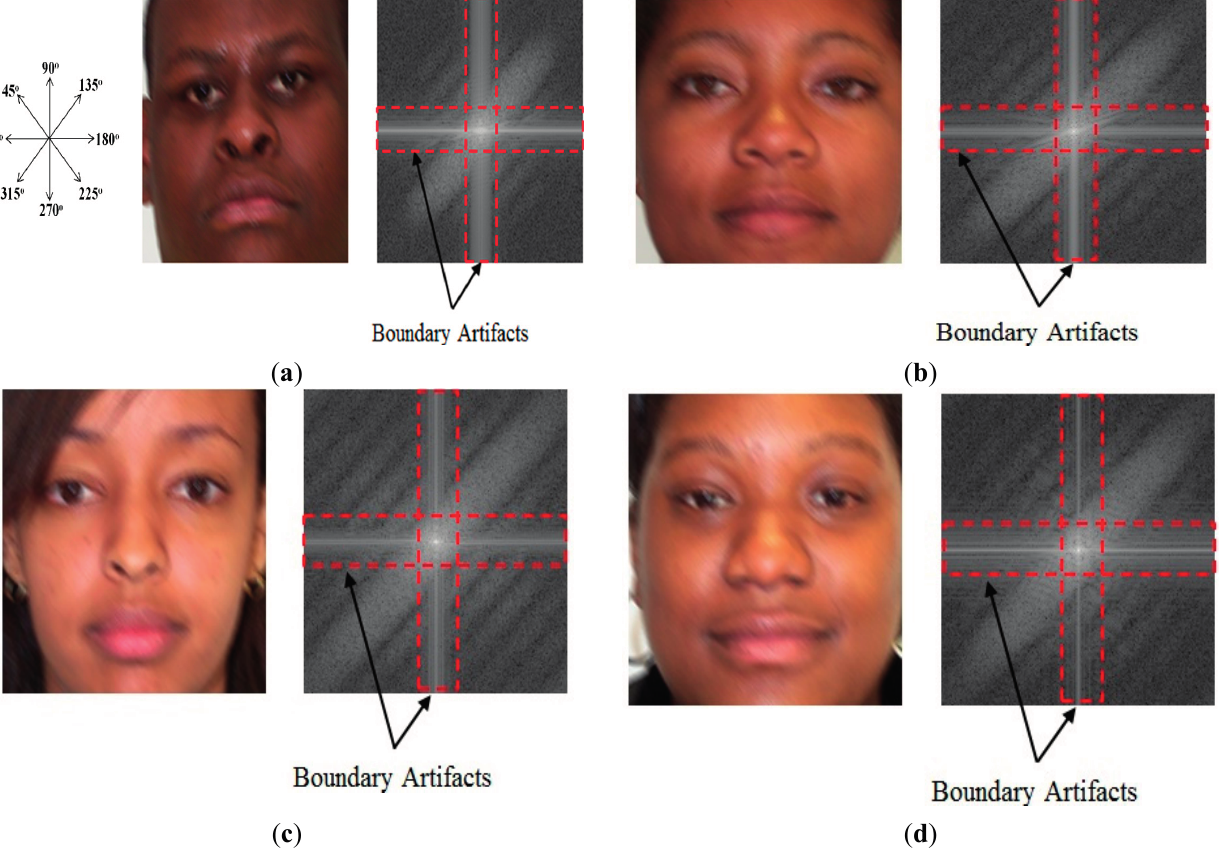
Figure 3. Examples of motion blurred images and their corresponding power spectrums with motion length of 7 and motion direction of 45°: ( a ) the first case of motion blurred image and its corresponding power spectrums with the indicator of motion direction; ( b – d ) the other cases of motion blurred images and their corresponding power